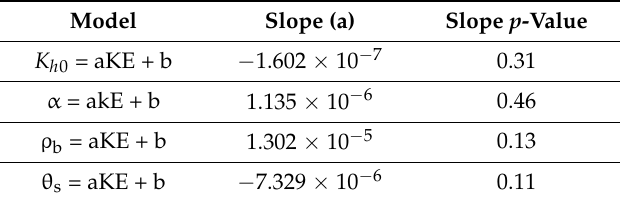
Table 3. Results of statistical hypothesis testing using Student’s t -test of the non-zero slope of the regression line between cumulative kinetic energy KE and soil physical properties: unsaturated hydraulic conductivity K h 0 , van Genuchten’s α , bulk density ρ b and saturated water content θ s . 13 data points were used for every test. The a stands for the slope and b for the